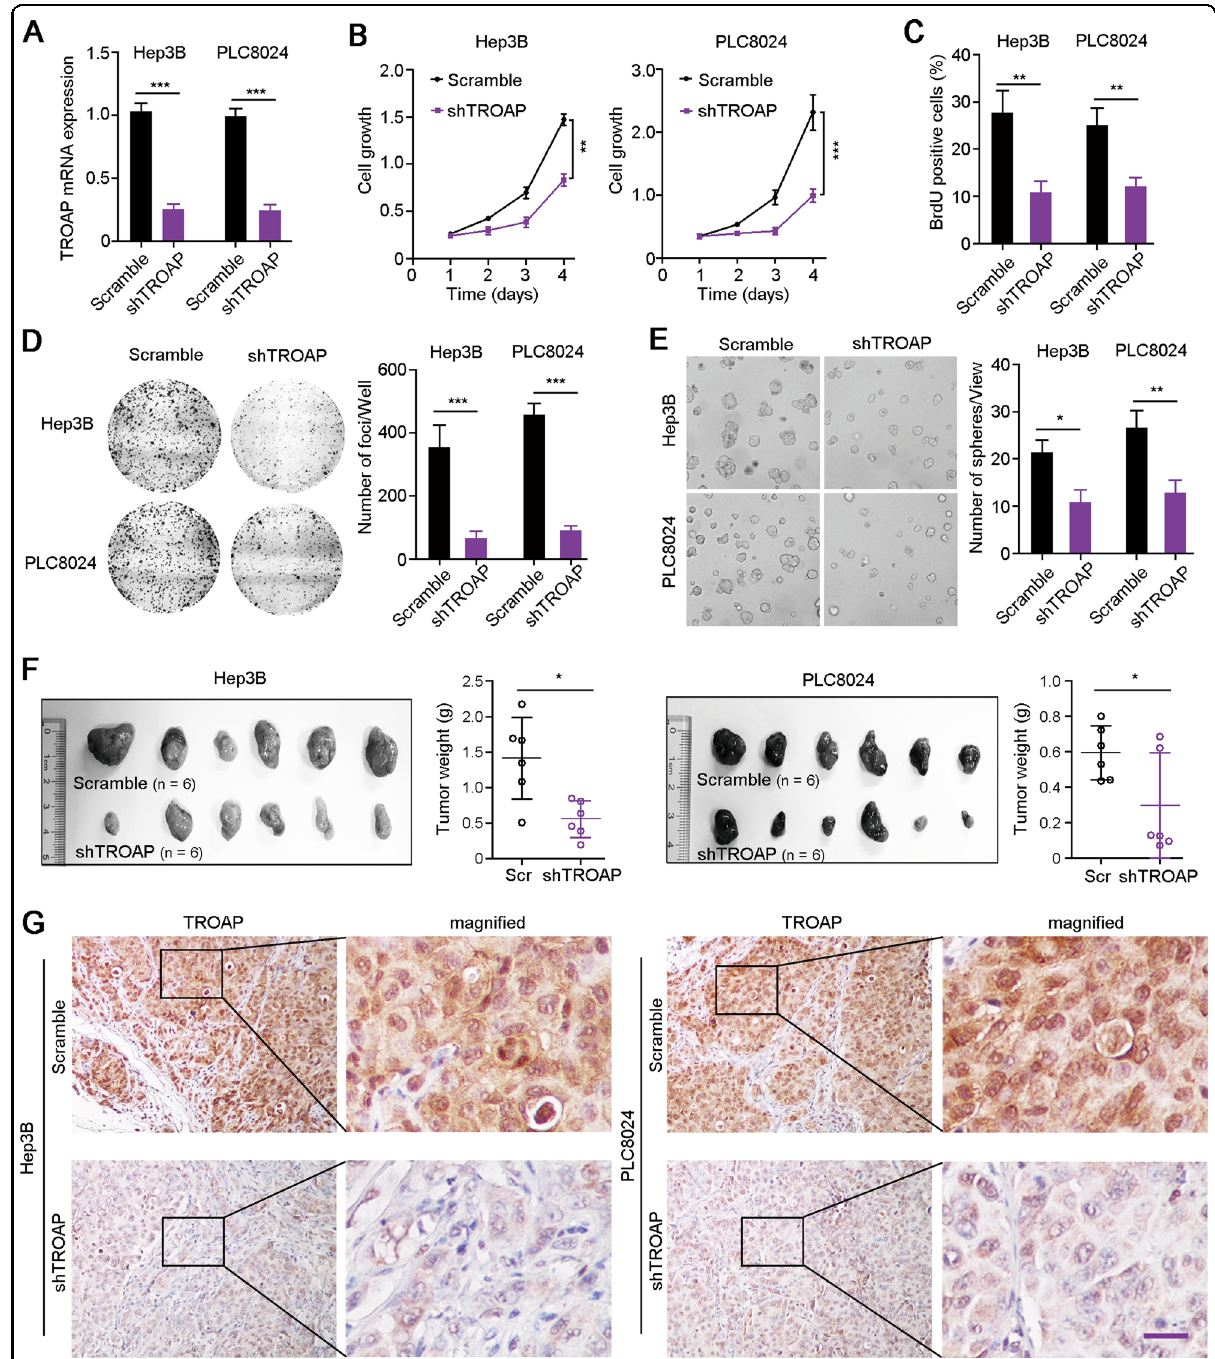
Fig. 3 Downregulation of TROAP attenuates the malignant proliferation of HCC cells in vitro and in vivo. A The downregulation of TROAP in Hep3B and PLC8024 cells after lentivirus-mediated silence of TROAP was con fi rmed by qRT-PCR. Cell growth ( B ), BrdU incorporation ( C ), foci formation ( D ), and sphere formation ( E ) assays were used to analyze HCC cell proliferation after knockdown of TROAP. Scramble vector was also transfected as a control. F Hep3B and PLC8024 cells transfected with shTROAP or scramble control were subcutaneously injected into nude mice. Three weeks after injection, tumor weights were measured. G IHC staining con fi rmed the knockdown of TROAP in xenograft tumors derived from TROAP-silenced HCC cells. Scale bar, 50 μ m. In panels B – F , data are indicated as mean ± SD; two-sided Student ’ s t -test; * P < 0.05; ** P < 0.01; *** P <